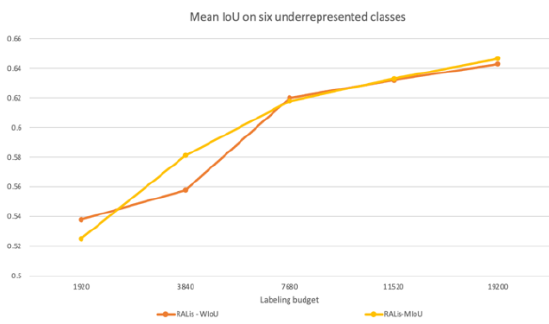
Figure 5. Mean IoU on six underrepresented classes